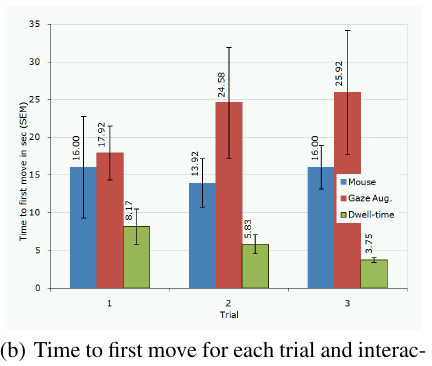
Figure 4 . Performance measures.